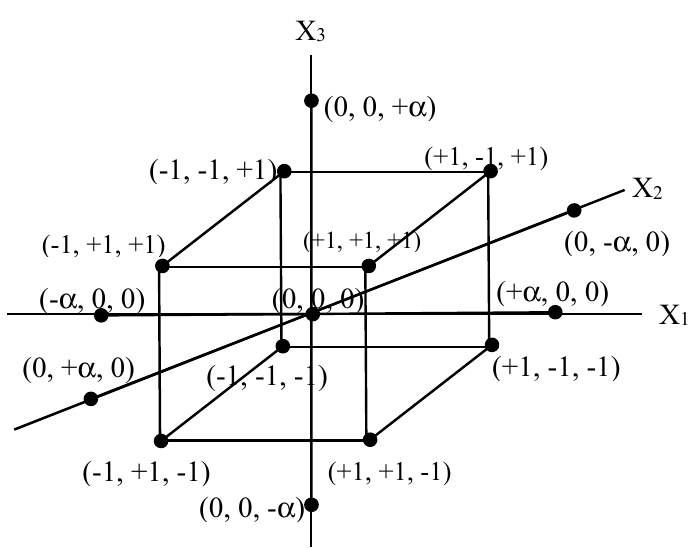
Figure 1. CCD Model of Bricket Material Prepared from Palm Stem Biomass (Modified from